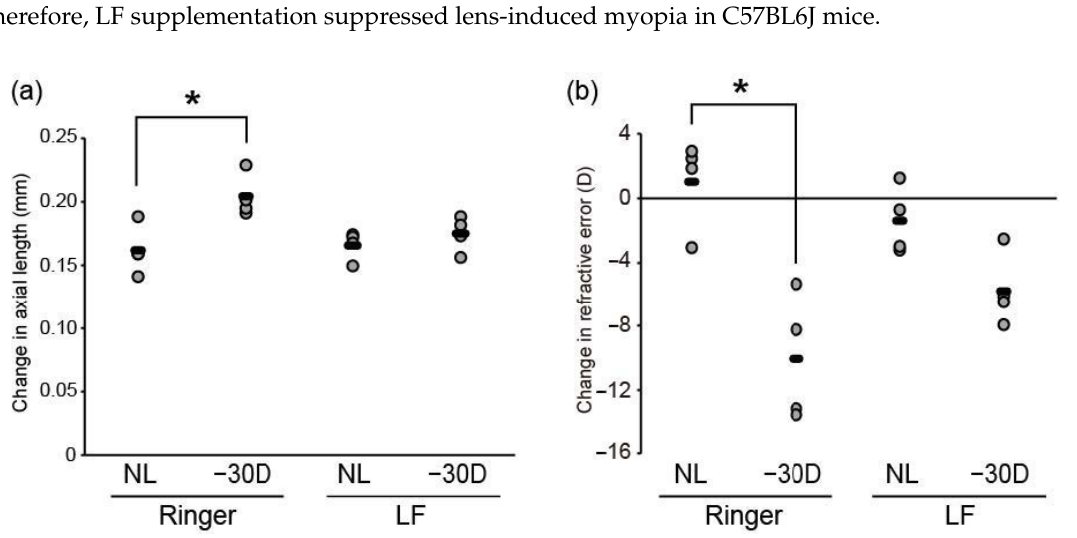
Figure 2. Scleral ER stress suppression or induction was sufficient to modulate axial elongation. ( a ) lens-induced myopia (LIM)-induced axial elongation was inhibited by oral administration of LF (lactoferrin) for 3 weeks ( n = 4 per group); * p < 0.05. ( b ) LIM-induced myopic shift in refraction was inhibited by oral LF administration for 3 weeks ( n = 4 per group); * p < 0.05.